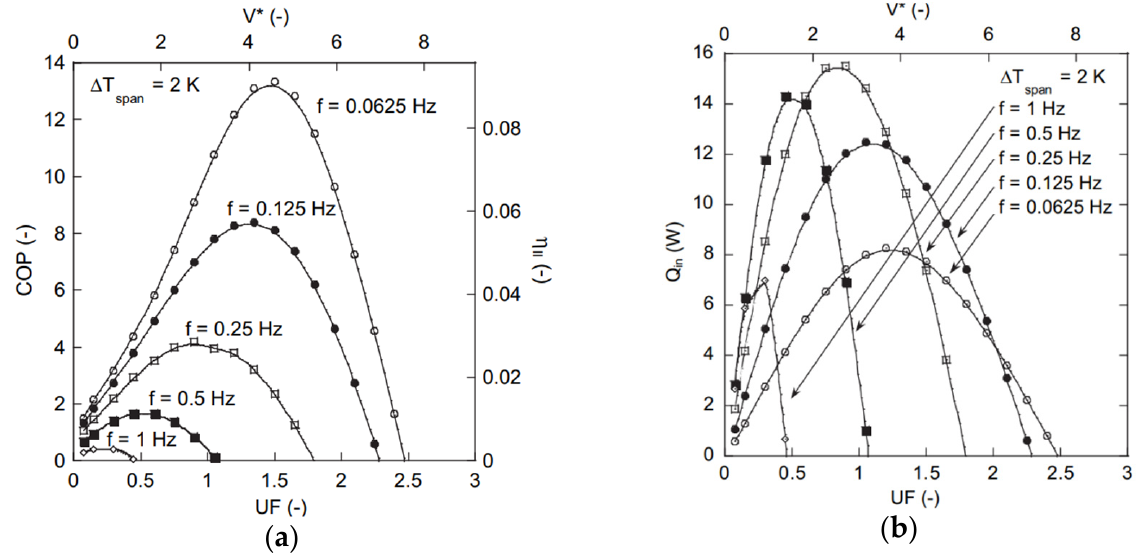
Figure 19. Simulation results of ( a ) COP and ( b ) cooling load versus the utilization factor UF, the ratio of the displaced fluid volume on the total fluid volume in the regenerator for different frequencies [68].